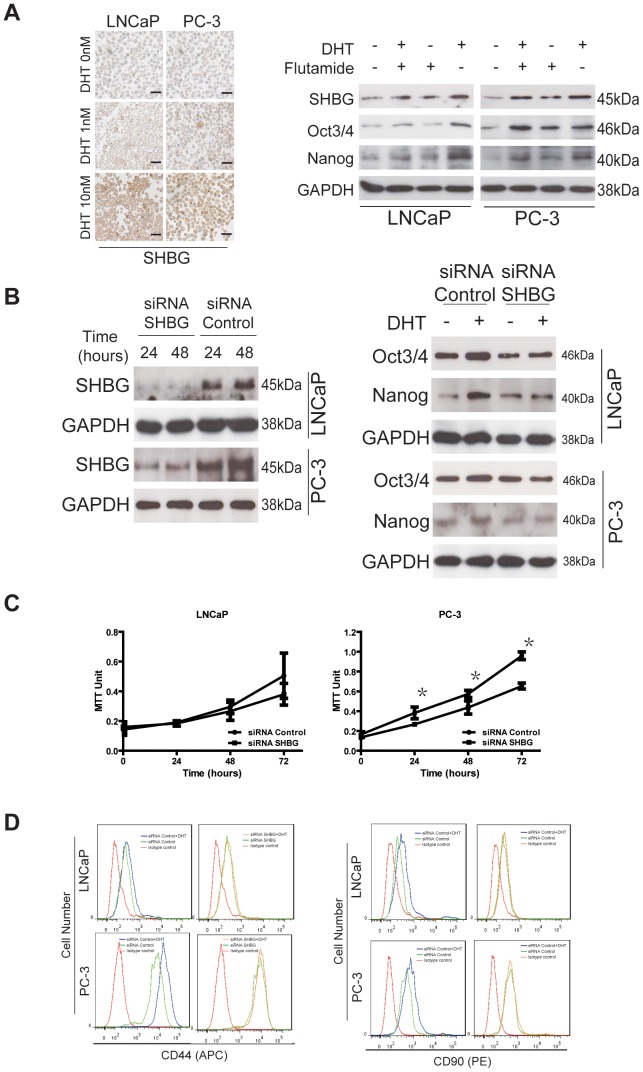
DHT upregulates the expression of stemess factors through SHBG.(A) Stronger immunocytochemical staining of SHBG is shown in LNCaP and PC-3 cells treated with DHT (left panel, bar scale: 50 µm). Immunoblotting demonstrates higher levels of SHBG, Oct3/4 and Nanog expressions in the cells treated with DHT (right panel). (B) SHBG specific siRNA results. SHBG knockdown in both LNCaP and PC-3 cells was verified by immunoblotting (left panel); 10 nM DHT induces expressions of Oct3/4 and Nanog in the cells transfected with the siRNA control, but such an induction disappears in the cells transfected with the specific SHBG siRNA (right panel). (C) LNCaP and PC-3 cells treated with specific SHBG siRNA grow relatively slower compared to the cells cultivated with control siRNA. (* means P<0.05). (D) Flowcytometry of CD44 and CD90 (left and right panel, respectively). While 10 nM DHT treatment for 48 hrs induces its expression in both cell lines for both genes (left parts of both panels), there is no CD44 and CD90 expression difference in these cells after specific SHBG siRNA knockdown compared to the siRNA control cells (right parts of both panels).